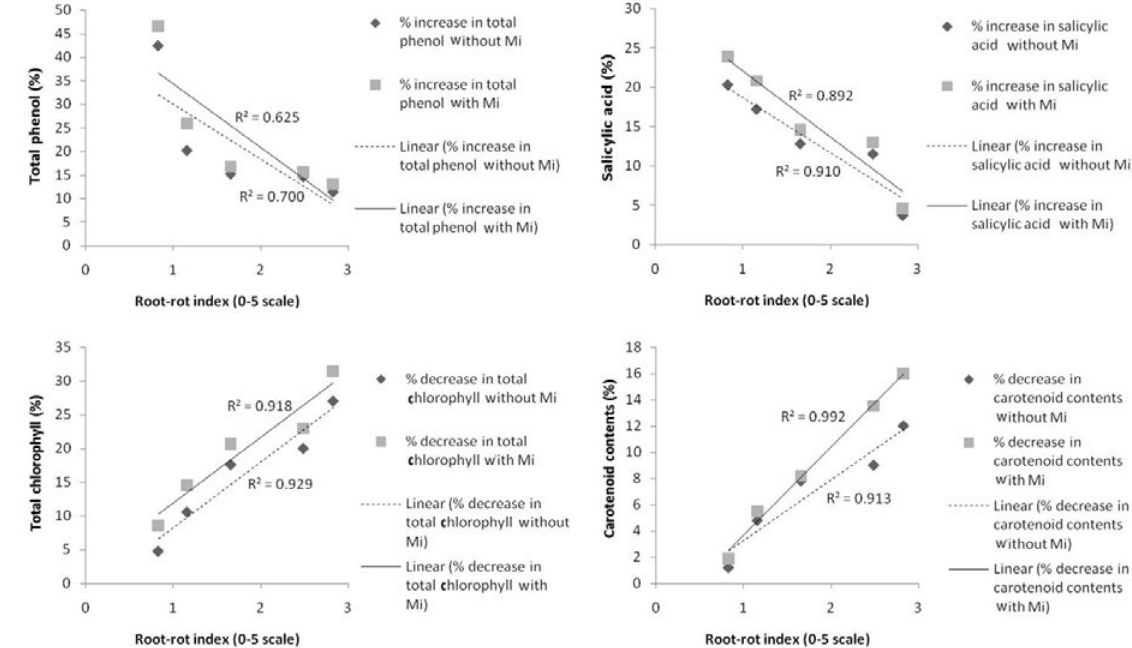
Figure 3. Correlations between root rot indices and percent variation in phenolic content, salicylic acid, total chlorophylls and carotenoids in tobacco cultivars inoculated with Pythium aphanidertmatum (Pa).